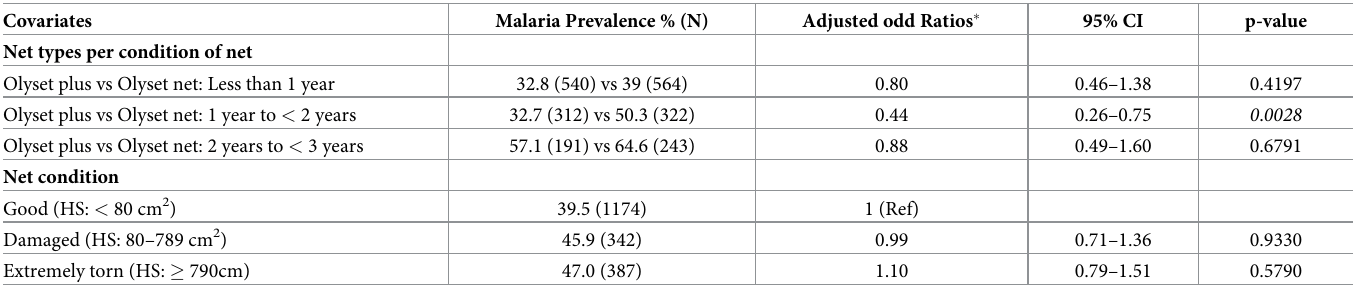
Table 6. Multivariable adjusted odds ratios of malaria infection among 0.5–14-year olds using nets with different physical conditions.